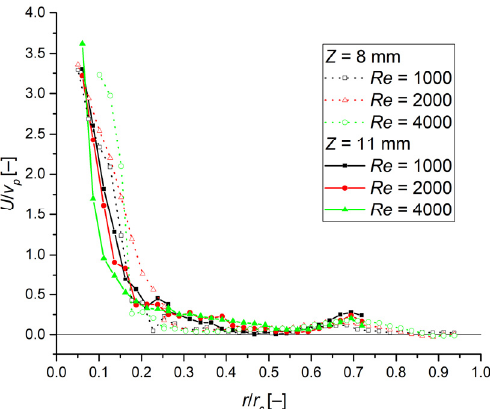
Figure 5. Swirl velocity profiles from LDA measurement, left for Re = 2000 and various Z positions. Right for Z = 2 and 13 mm for various Re .